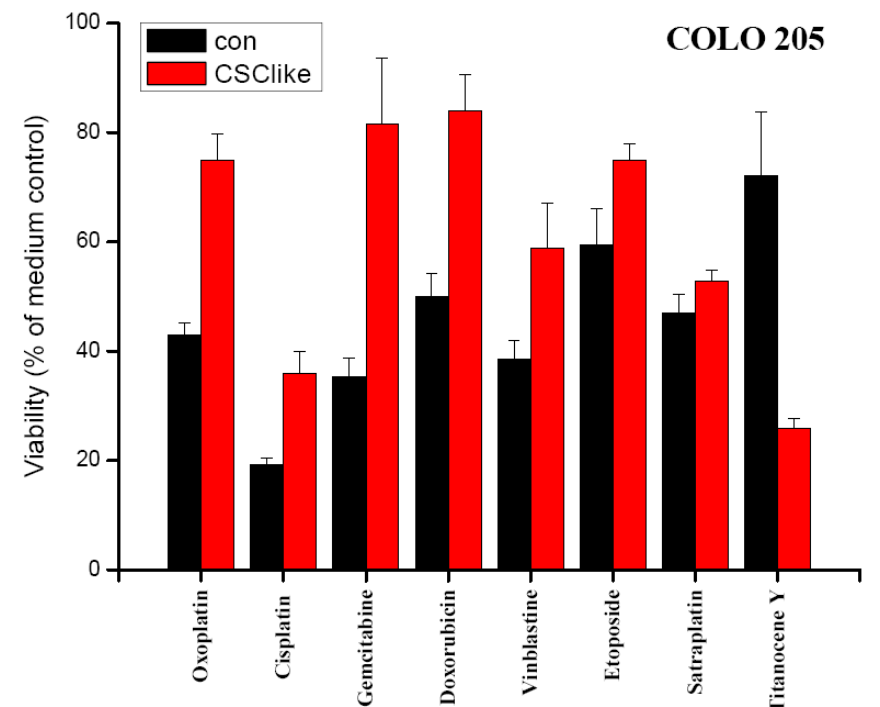
Figure 2. Comparison of chemosensitivities of COLO 205 cells precultivated in either standard medium or serum-free stem cell medium. Viability of COLO 205 colon cancer cells precultivated in either normal tissue culture (con) or stem cell medium (CSC-like) after exposure to a range of chemotherapeutics in normal tissue culture medium for four days in vitro (mean ± SD). All differences were statistically significant, except for